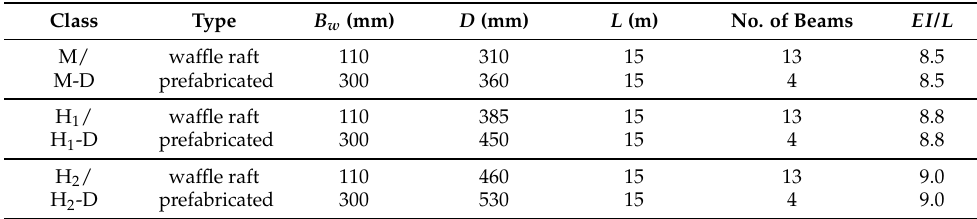
Table 2. Sections of the developed prefabricated footing system for each site